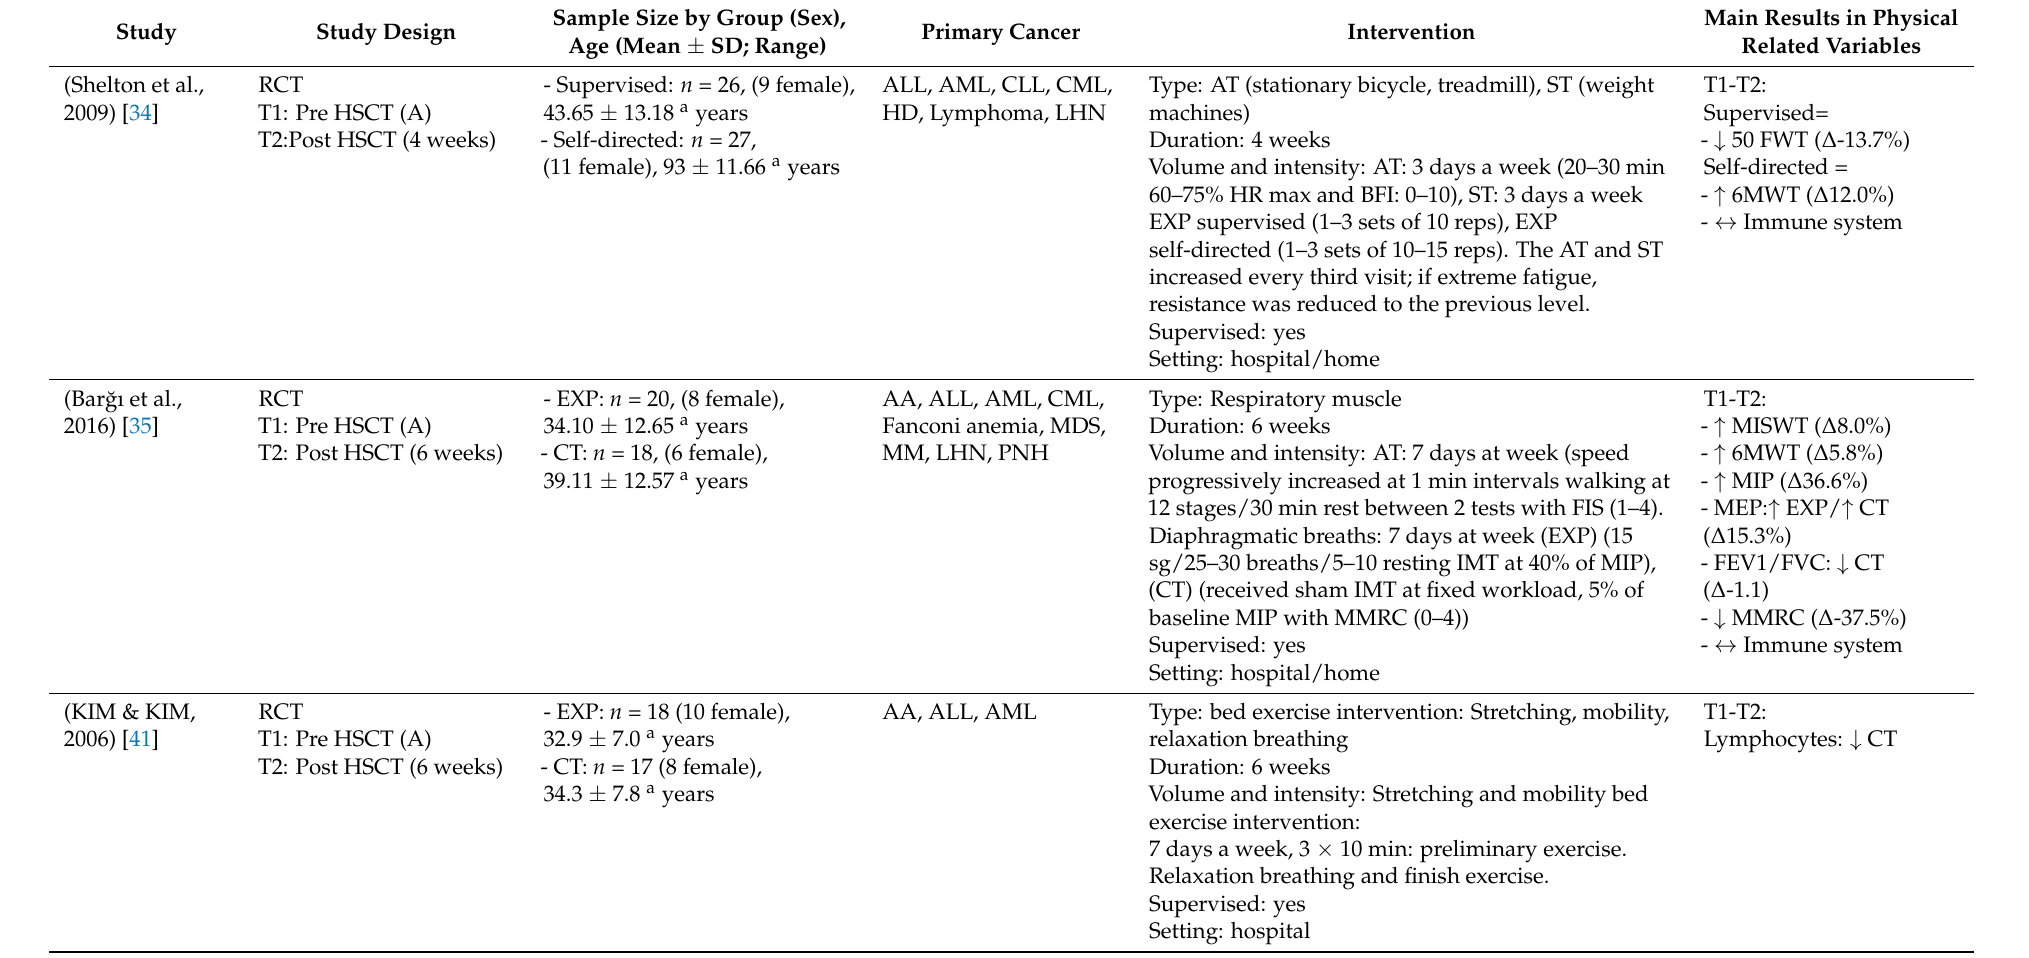
Table 3. Studies that have analyzed the effects of an exercise program after HSCT, with main results in physically related variables. Sample Size by Group (Sex), Study Study Design